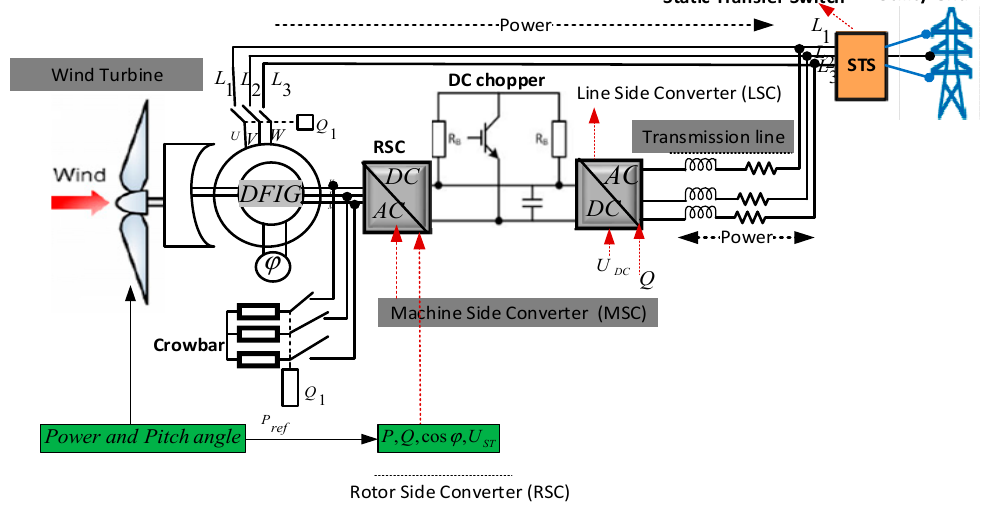
Figure 1. Diagram of a wind turbine with a Doubly Fed Induction Generator.